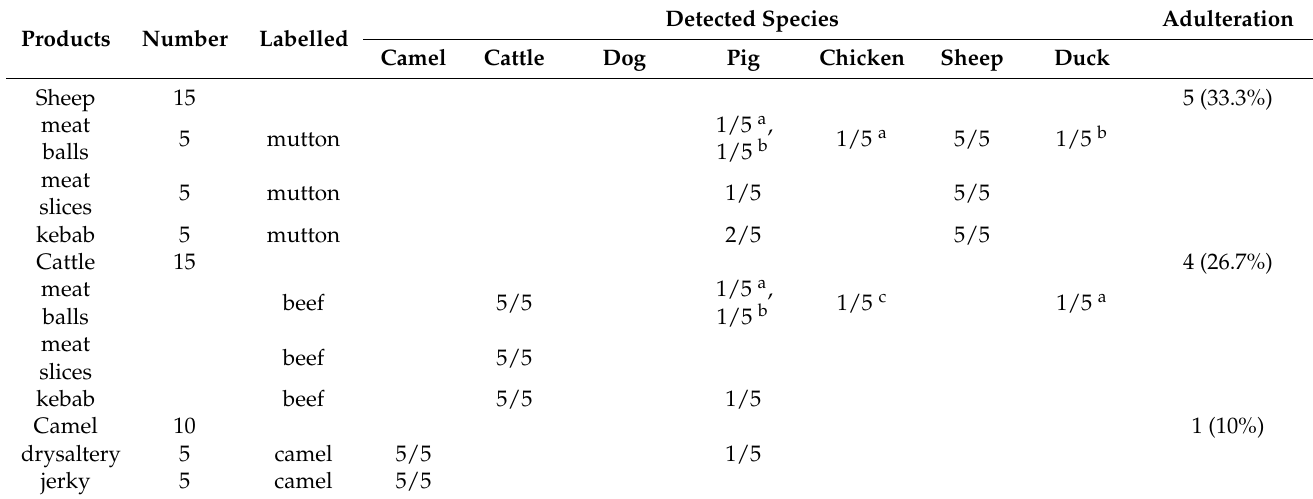
Table 2. Results of multiplex PCR assay performed on commercial meat